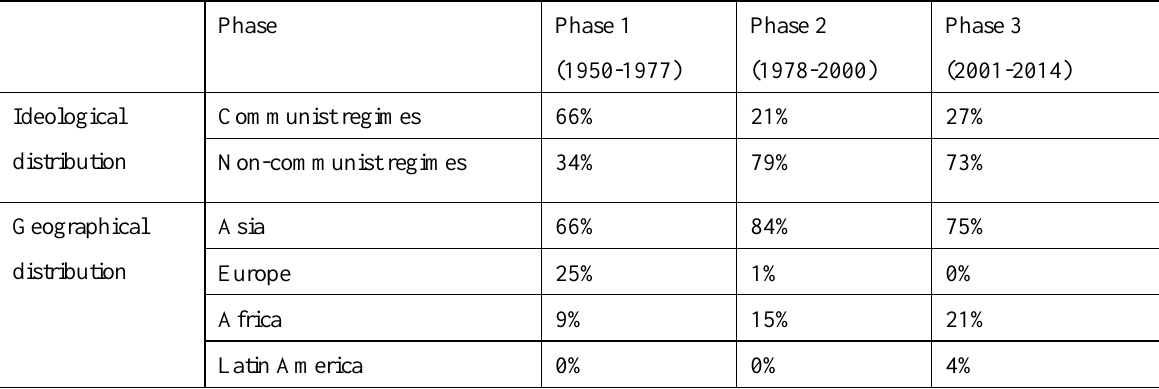
Table 2 . Ideological and geographical distribution of arms outflows from China